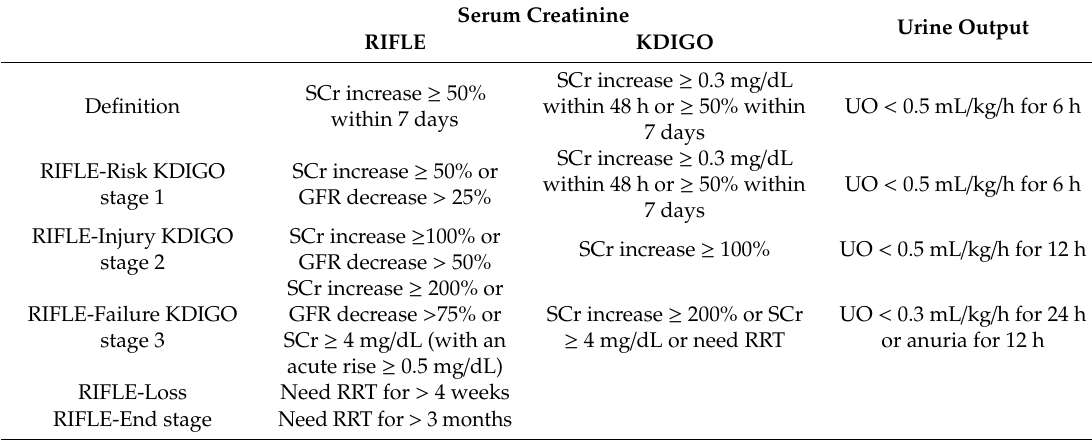
Table 1. Comparison of RIFLE and KDIGO